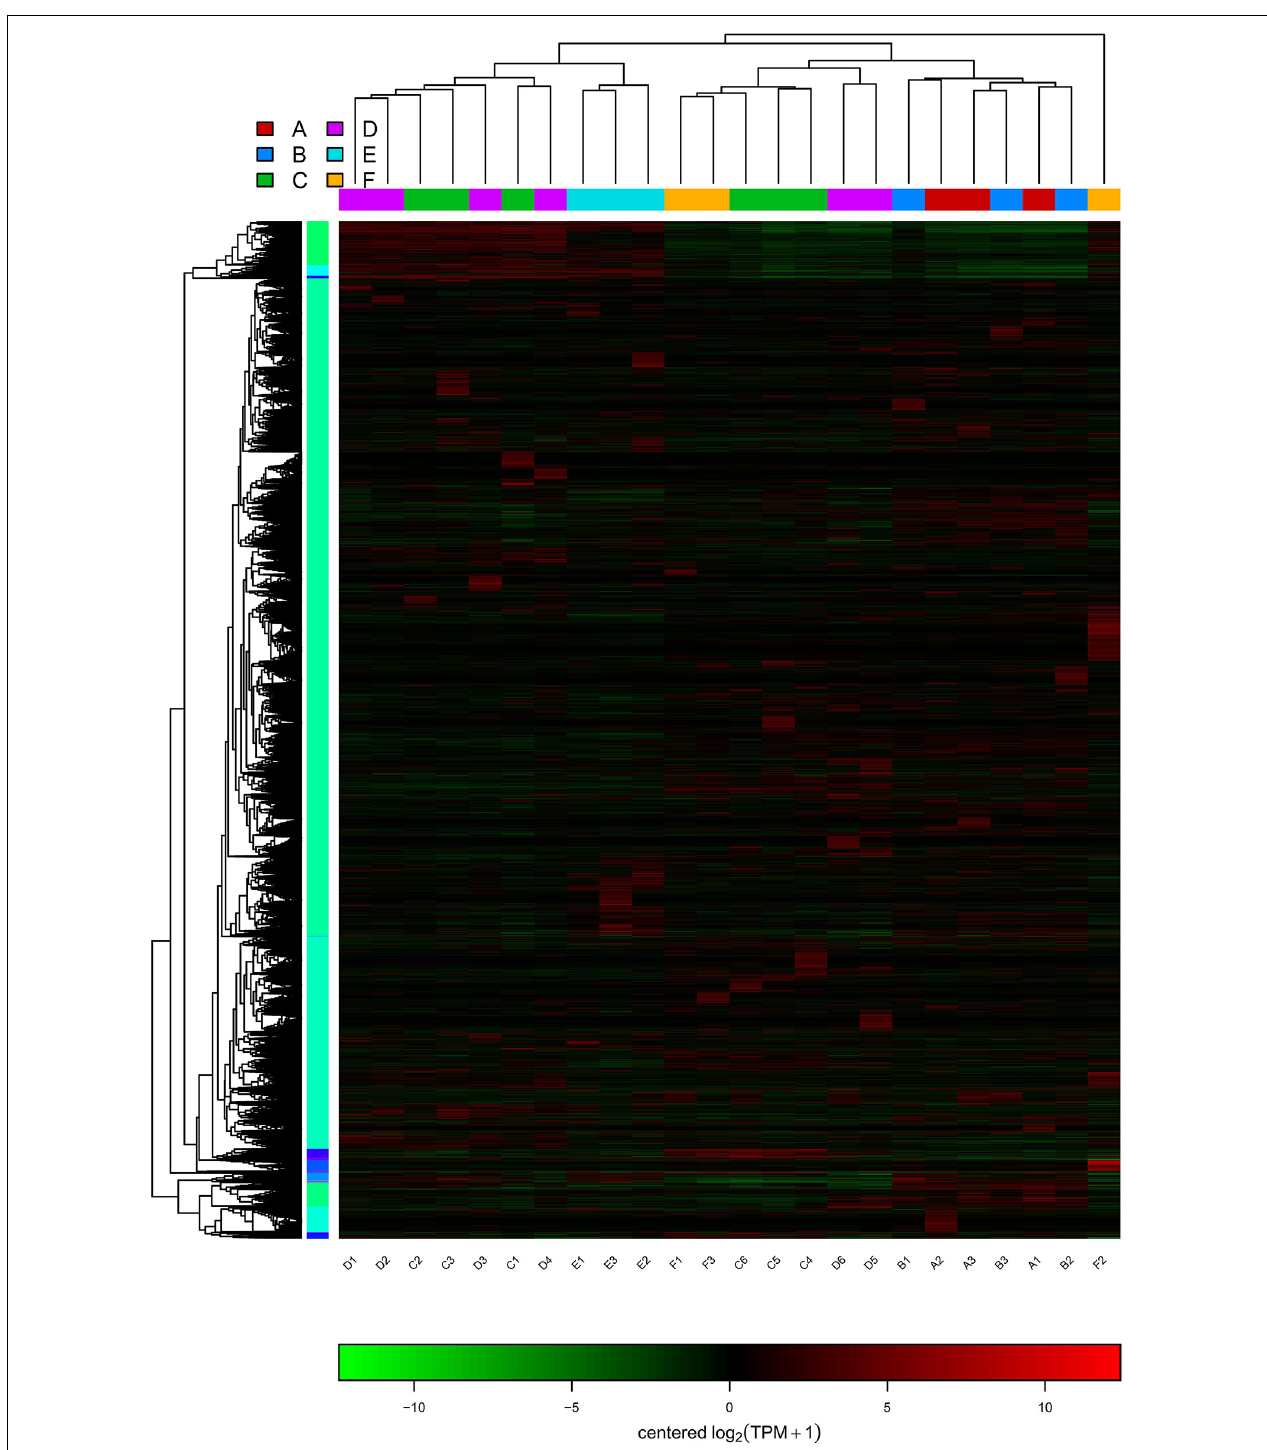
FIGURE 6 | The heatmap clustering of the differential genes between groups.